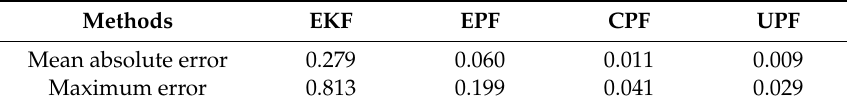
Table 3. Performance comparison of four methods in noise